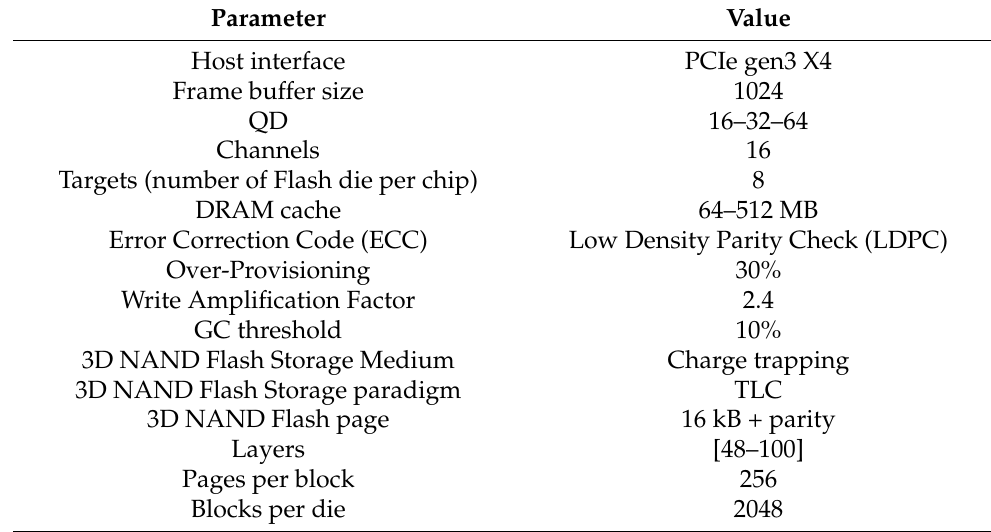
Figure 4. Electrical characterization of TLC 3D NAND Flash samples and SSD co-simulation flow adopted in this work for the program suspend study. Table 1. 3D NAND Flash and SSD architectural parameters considered in the